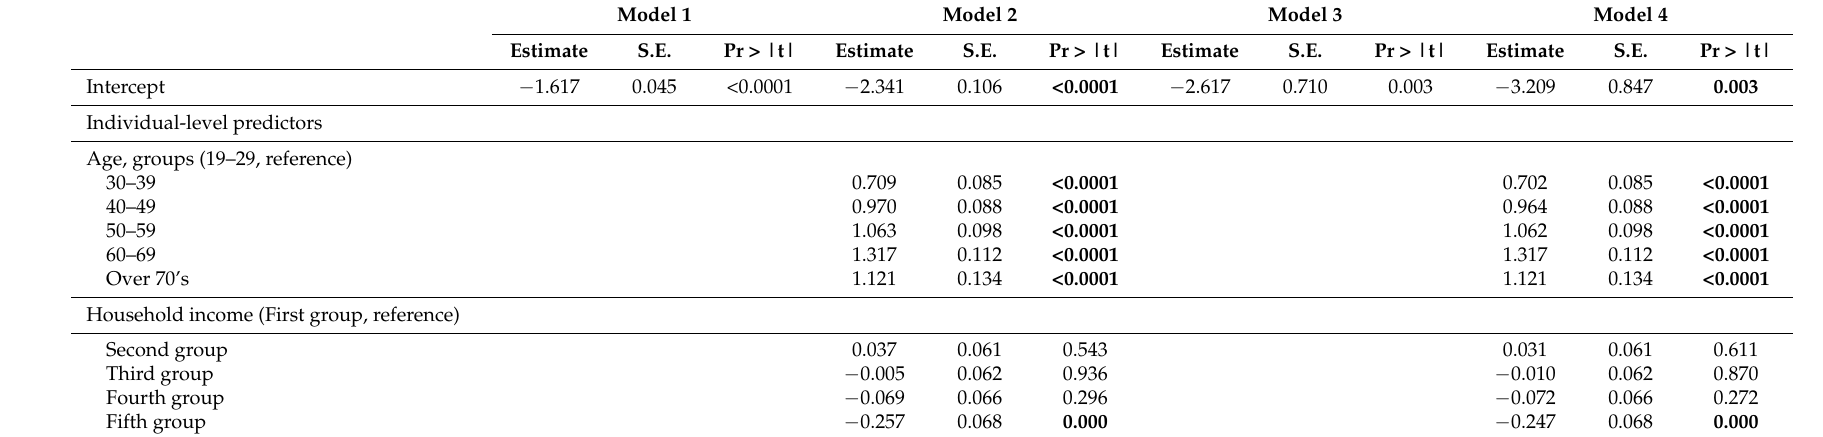
Table 3. Individual and environmental factors affecting obesity of women in Seoul based on multilevel analysis